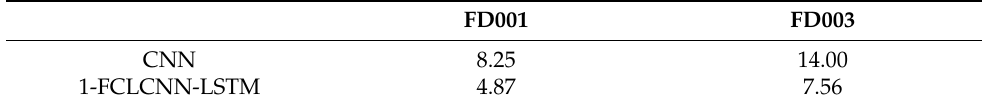
Figure 13. Training diagram of the same FD003 engine under two models. Table 5. RMSE training values of FD001 and FD003 under the two models. Table 5. RMSE training values of FD001 and FD003 under the two models. FD001 FD003 FD001 FD003 CNN 8.25 14.00 CNN 8.25 14.00 1-FCLCNN-LSTM 4.87 7.56 1-FCLCNN-LSTM 4.87 7.56